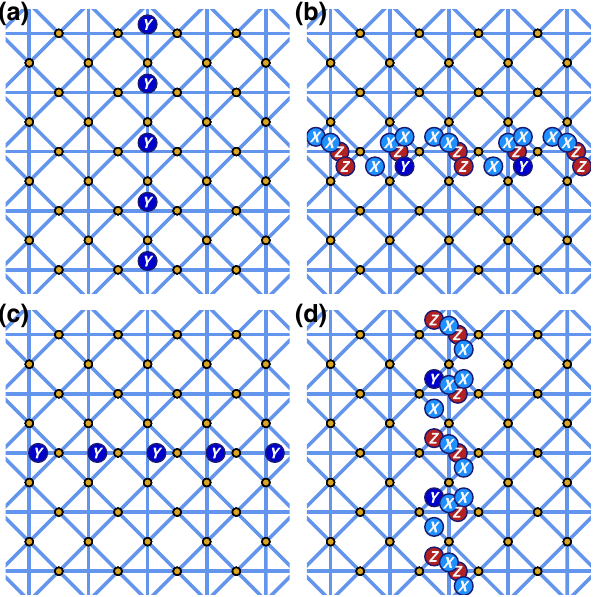
FIG. 3. Logical degrees of freedom of the checkerboard-lattice code. (a),(b) Stringlike logical X and logical Z operators that form an exact logical qubit and commute with all the Hamil- tonian and stabilizer terms shown in Fig. 2. (c),(d) A second stringlike logical pair that commutes with the first. On a torus with even dimensions, these are the only independent operators that commute with all the Hamiltonian and stabilizer